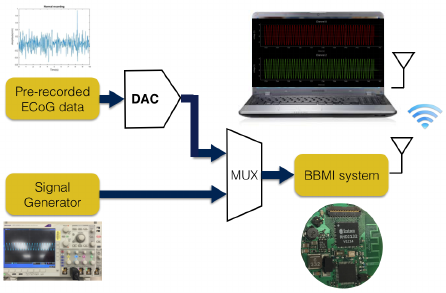
Figure 4. Experimental setup for the bench test with two input